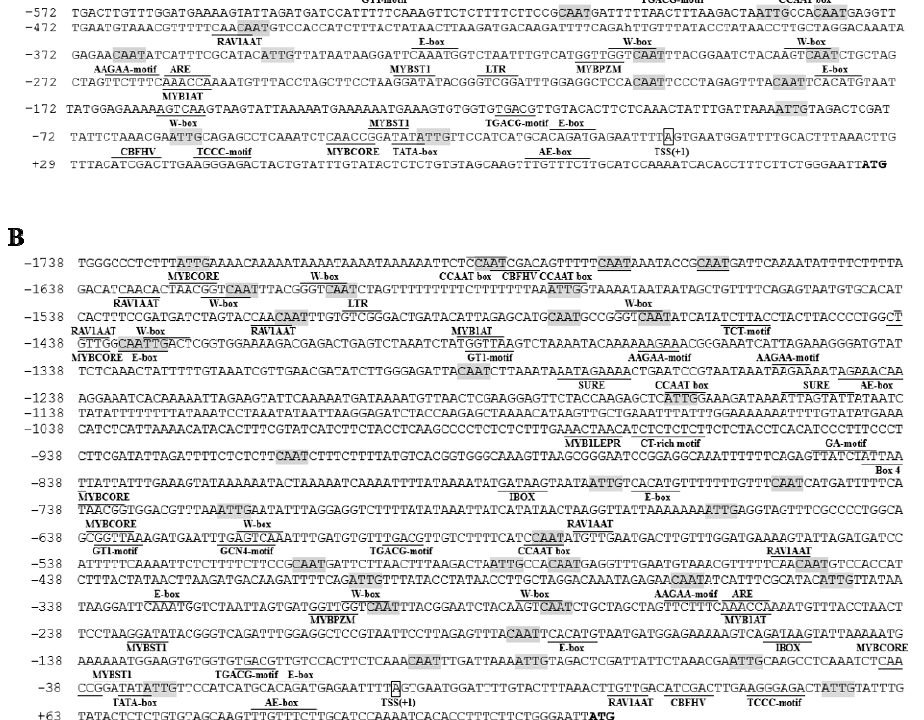
Figure 1. Putative cis -regulatory elements present in the TwTPS27a promoter ( A ) and the TwTPS27b promoter ( B ) using the PLACE and PlantCARE databases. Numbers indicate the positions relative to the transcription start site (TSS, assigned as position +1, with a box). Putative CAAT-box elements are shown in shaded. Underlined and overlined sequences represent predicted cis -regulatory elements.